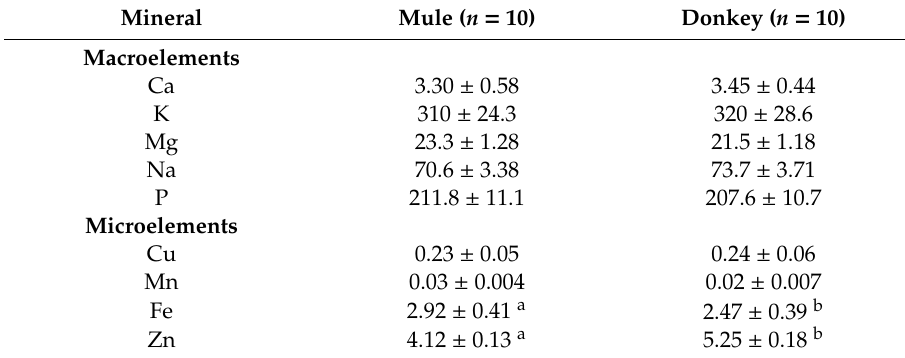
Table 4. Mineral content (mg / 100 g wet tissue) determined in mule and donkey Longissimus thoracis muscle (means ± SE).